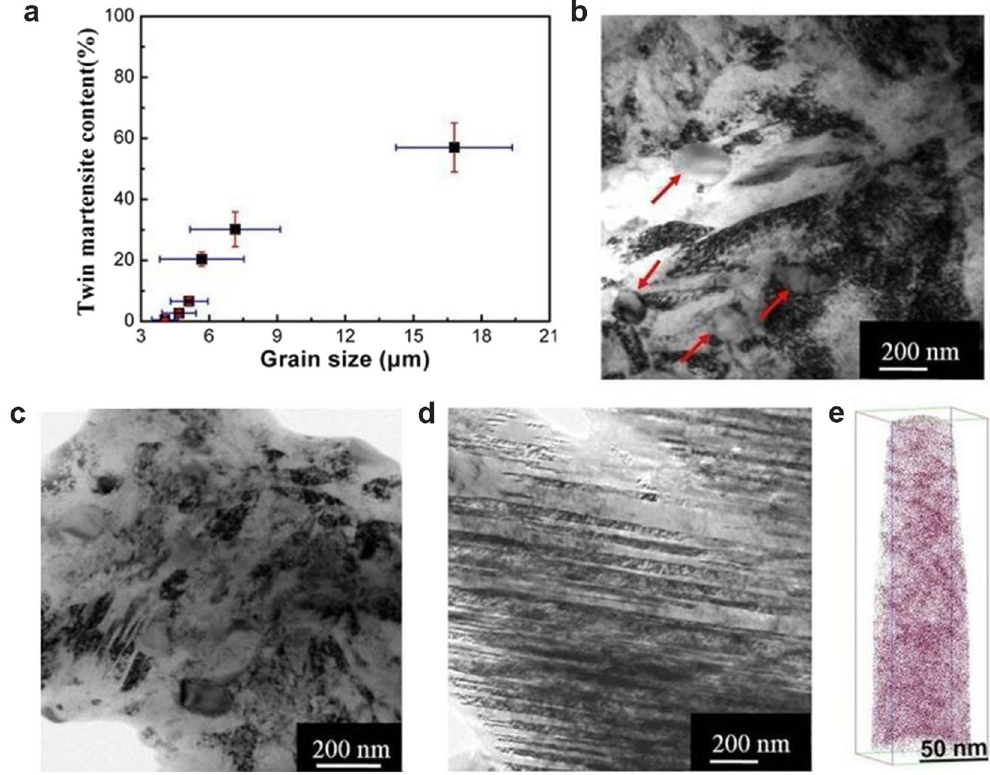
Figure 3. Grain size effect on martensitic substructure and carbon distribution in martensite matrix for an AISI52100 high carbon steel. ( a ) Influence of grain size on the fraction of twinned martensite. “Error bars” represent “standard deviations (s.d.)” ( b ) Full dislocation martensite at an average grain size of 4 μ m. ( c ) A mixture of dislocation martensite and twinned martensite at an average grain size of 5.3 μ m. ( d ) Fully twinned martensite at an average grain size of 16.8 μ m. ( e ) APT-reconstructed 3D distribution of carbon atoms in the fine-grained martensite steel with an average grain size about 4 μ